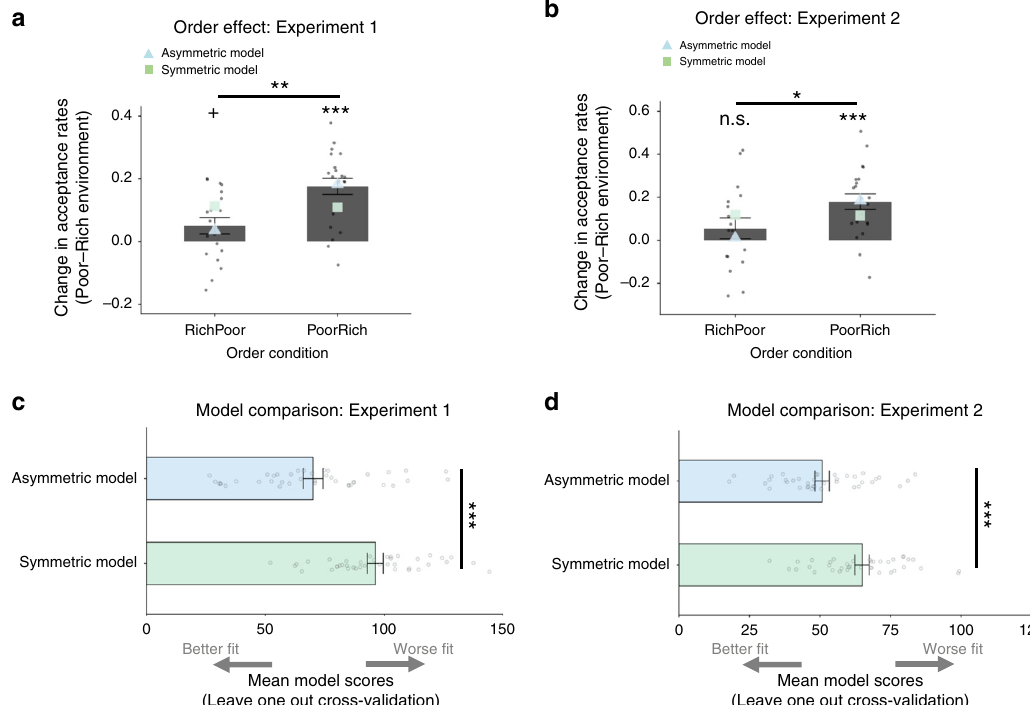
Fig. 3 Order effect and model comparison. a Participants who experienced the poor environment followed by the rich environment (PoorRich group, N = 21) changed choices between environments to a greater extent than participants who experienced a rich environment followed by a poor (RichPoor group, N = 19) environment ( t (38) = 3.41, p = 0.002, two-tailed independent t -test comparing the change in acceptance rates between these two groups of participants). The Asymmetric Model was able to recapitulate this order effect by having separate learning rate for when reward rate estimates increased and when they decreased. The Symmetric Model which had a single learning rate predicted that the change in acceptance rates between environment ought to be the same for RichPoor and PoorRich participants. Gray dots represent individual data points and gray bars represent the group mean. Blue triangles represent the pattern of choices generated by simulations from the Asymmetric Model. Green squares represent the pattern of choices generated by simulations from the Symmetric Model. b This pattern of results replicated in a second experiment ( t (36) = 2.08, p = 0.045, two-tailed independent t -test comparing the change in acceptance rates between these two groups of participants) (PoorRich group, N = 21; RichPoor group, N = 17). c The Asymmetric Model provided a superior fi t to the data than the Symmetric Model in Experiment 1 ( t (39) = 7.20, p = 1.1551E-8, two-tailed paired sample t -tests comparing LOOcv scores for the Asymmetric versus the Symmetric Model. Plotted are the mean LOOcv scores over subs ( N = 40) for each model. d The Asymmetric Model provided a superior fi t to the data than the Symmetric Model in Experiment 2 as well ( t (37) = 6.04, p = 5.4824E − 7, two-tailed paired sample t -tests comparing LOOcv scores for the Asymmetric versus the Symmetric Model). Plotted are the mean LOOcv scores over subs ( N = 38) for each model. Dots represent individual data points and bars represent the group mean. Error bars represent mean ± standard error of the mean. + 0.05 < p < 0.10; * p < 0.05; ** p < 0.01; *** p < 0.001: independent sample t -test/paired sample t -test/one-sample t -test (vs. 0) as appropriate (all two tailed) n.s. non-signi fi cant. Source data are provided as a Source Data fi